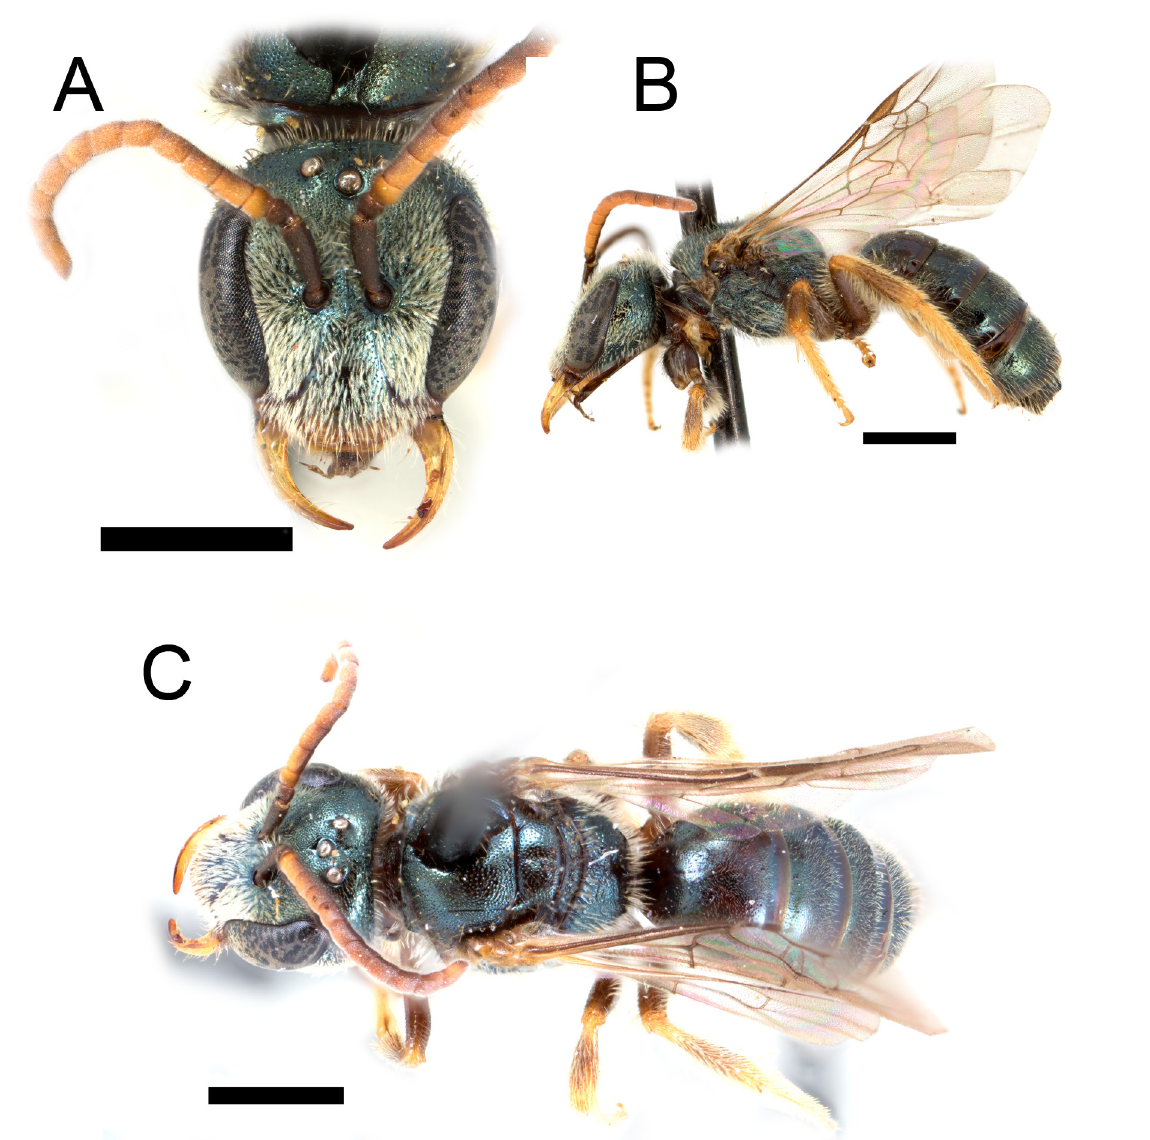
Fig. 16. Lasioglossum ferrerii (Baker, 1906), ♂. A . Face. B . Lateral habitus. C . Dorsal habitus. Scale bars = 1